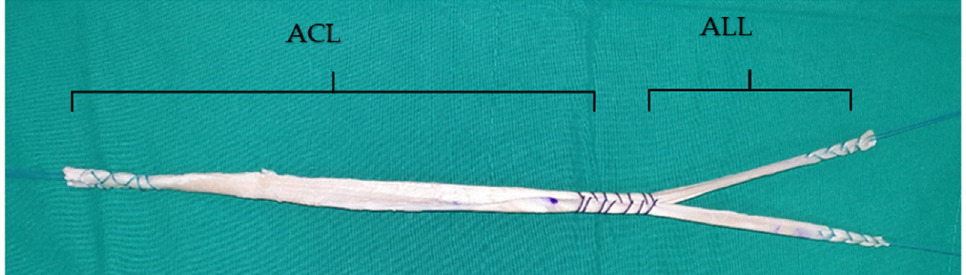
Figure 2. Graft preparation for combined ACL and ALL reconstruction using a single Achilles tendon allograft. The allograft is trimmed into a Y-shape graft with two portions: an ACL portion and a two-bundle ALL portion.